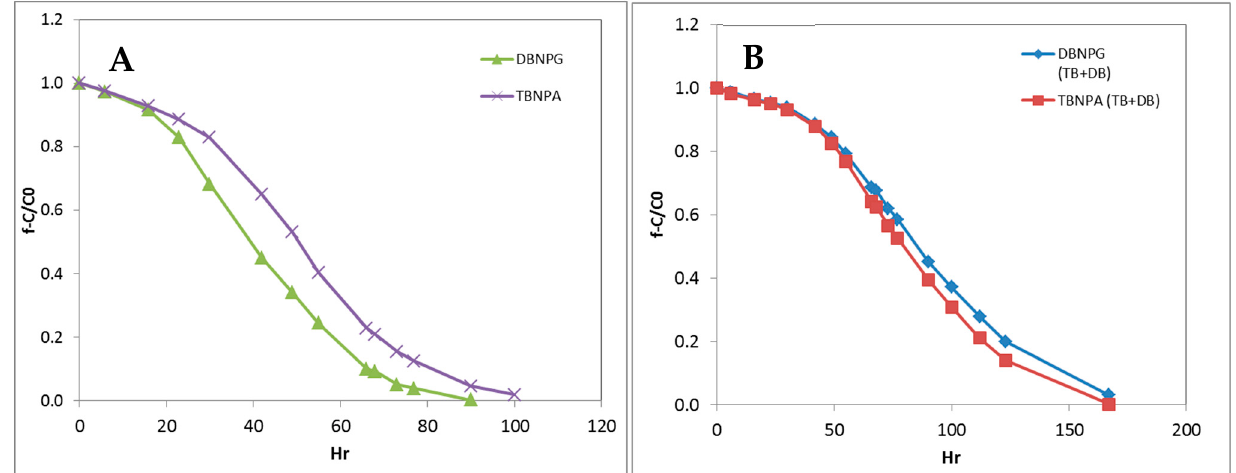
Figure 2. Microbial degradation during ( A ) separate (100 mg L − 1 each) and ( B ) concurrent (50 mg L − 1 each) supplement of DBNPG and TBNPA with the four-strain consortium and yeast extract amendment (Table 1). For ( A ) Each point represents one triplicate; ( B ) each point represents 3 replicates with standard deviation error bars.